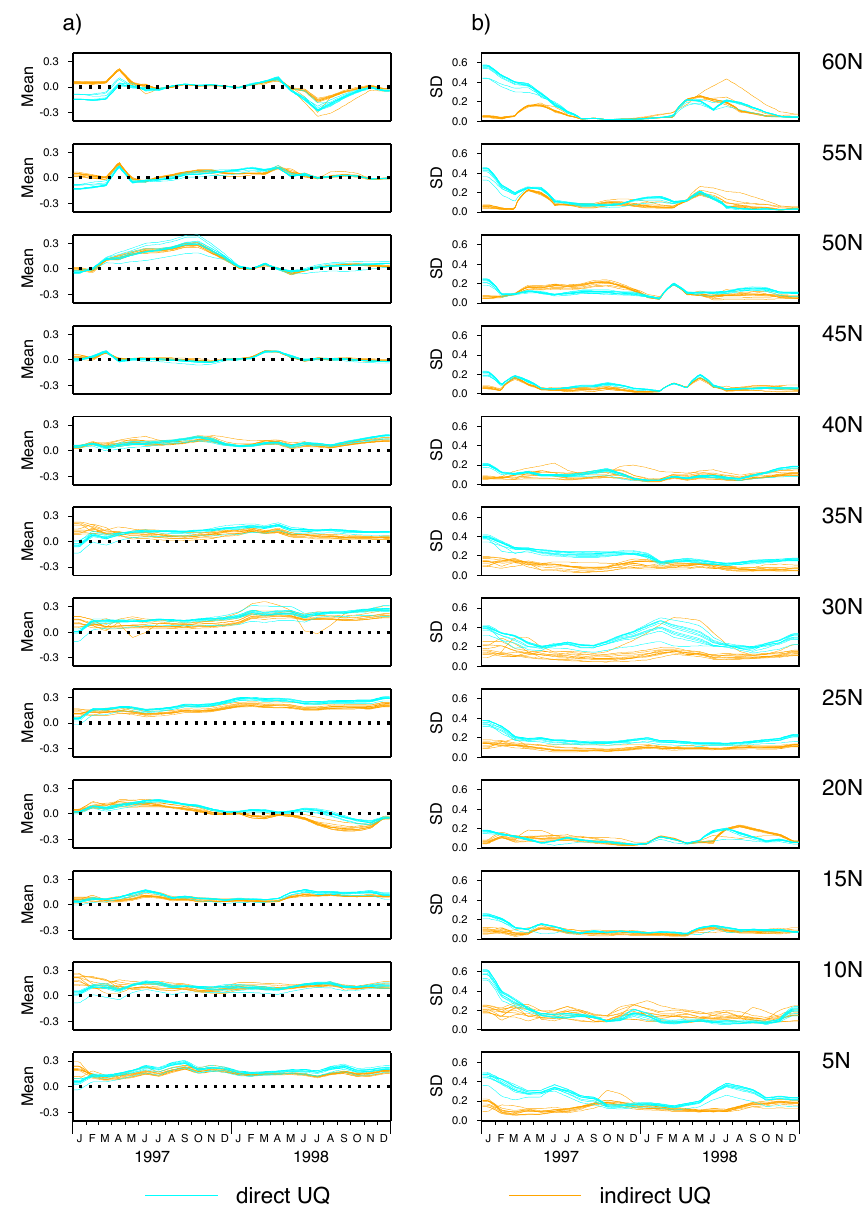
Figure B1. Statistics for the uninformed simulator residual (cid:15) 1 , predicted by the direct and indirect uncertainty quantification methods for all 10 experiments: (a) residual means u 1 and u S + u B ; (b) residual standard deviations s 1 and with chlorophyll in mgm − 3